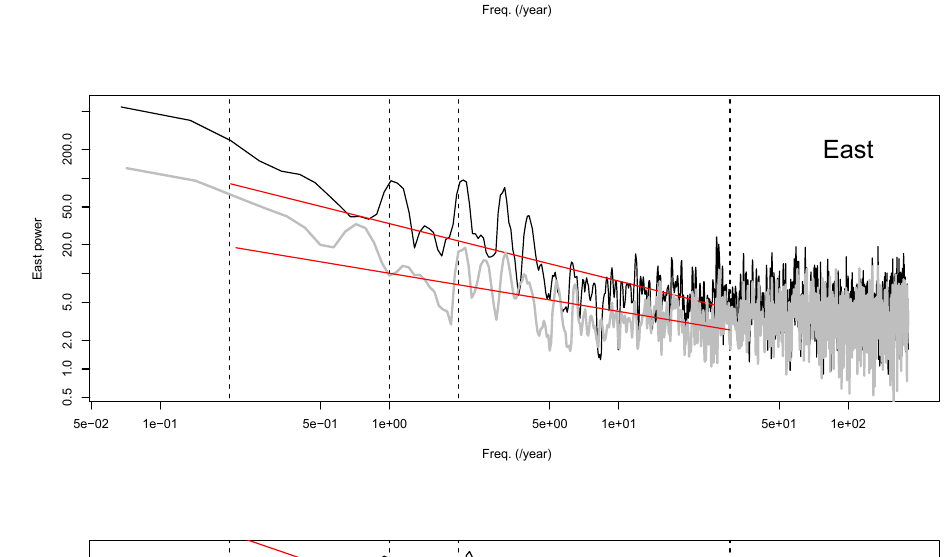
The dispersion of the horizontal velocities (Fig. 7) and vertical velocity vs. altitude correlation (Fig. 10) shows that we can resolve sub-millimeter horizontal and vertical veloc- ities in the Alps and the Pyrenees. Furthermore, the indepen- dent result obtained with leveling in the Western Alps (Noc- quet et al., 2016) shows that the uplift motion on the order of 1 mm yr − 1 is significant. Strain rate computation (Fig. 8)